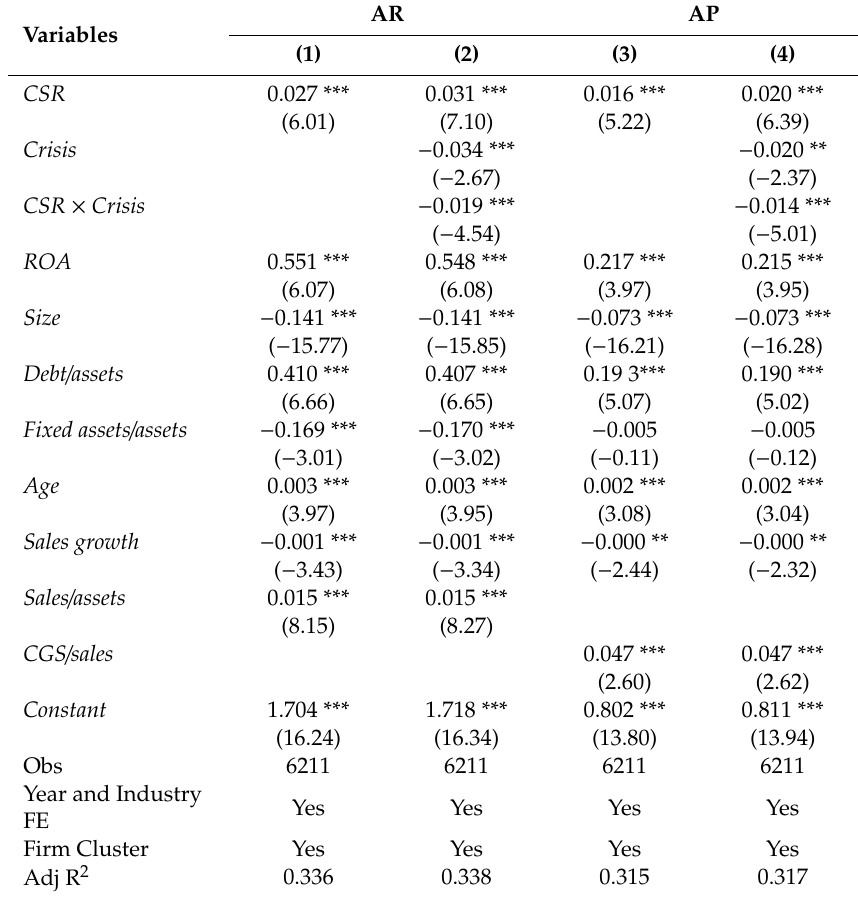
Table 4. Corporate social responsibility, financial crisis, and trade